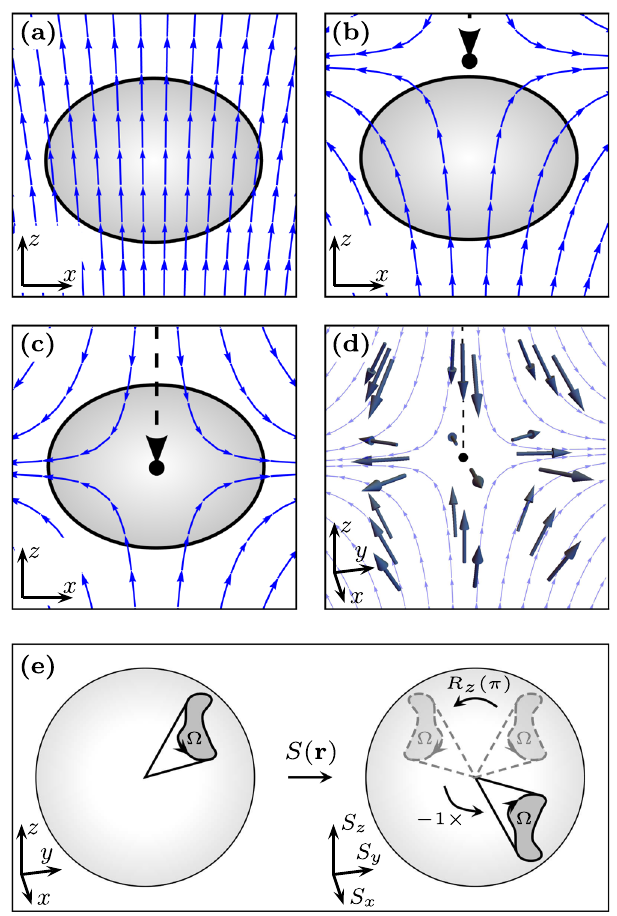
FIG. 1. (a – c) Control sequence of the external quadrupole magnetic field (blue thin arrows) during the creation process of an isolated monopole (Dirac monopole) in the polar (ferromagnetic) phase of the spin-1 BEC and (d) the theoretical spin configuration generating a Dirac monopole. The zero point of the quadrupole magnetic field, indicated by the black dot, is (a) well above, (b) approaching, and (c) in the middle of the condensate (shaded ellipse). The dashed arrow in (b – d) shows the path traced by the zero point as it is adiabatically brought into the condensate. In (d), the directions of the thick arrows indicate the direction of local spin, aligned with the quadrupole field, at selected points in space. (e) Mapping of a closed path on a spherical surface enclosing a solid angle Ω from the real space to the spin space in the Dirac monopole spin configuration (see Sec. II C). In the spin π Þ can be used to space, we illustrate how an operation − R z ð implement the